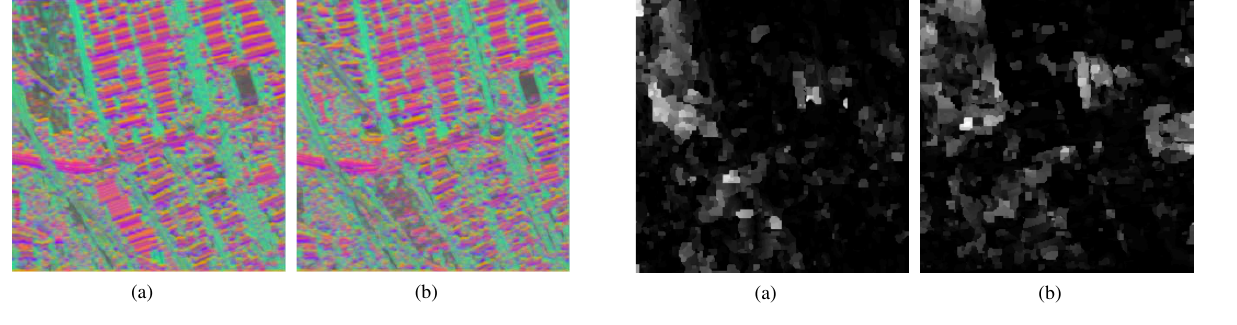
Figure 3: Illustration of the distance space presented in this paper. (a)change vector field in horizontal direction. (b)change vector field in vertical